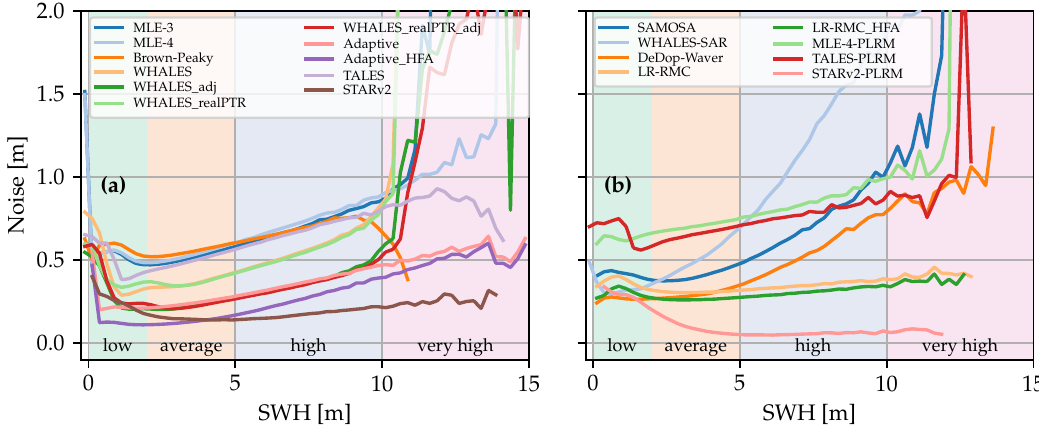
Figure 7. Noise level of the individual retrackers as a function of significant wave height (SWH) for ( a ) J3- and ( b ) S3A-retracking algorithms with the sea state noted at the bottom. Comparing the noise level of the standard retrackers MLE-4 and SAMOSA (LRM vs. DDA)